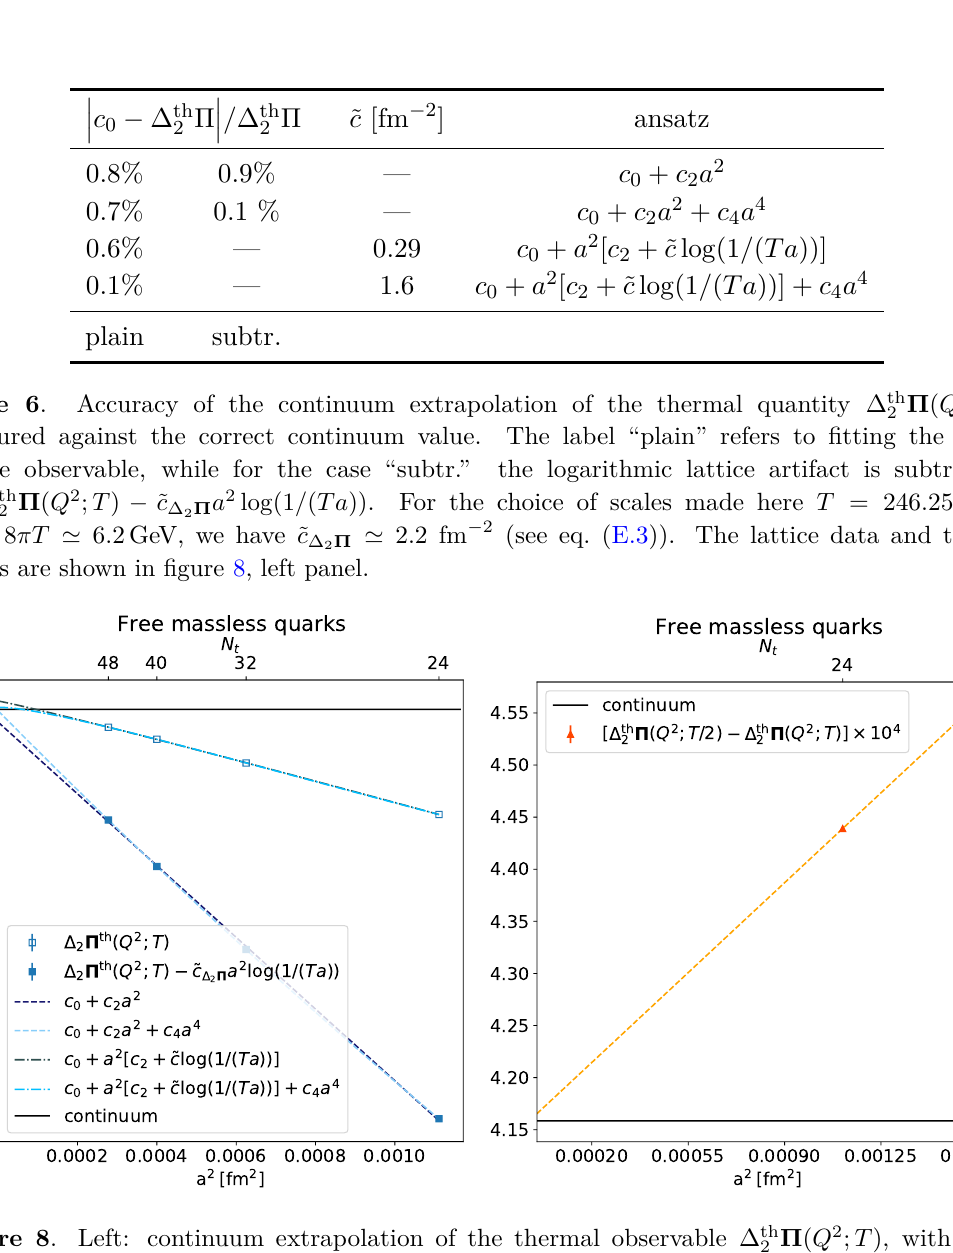
2 N = 48 for the temperature- T/ 2 one, the difference between the lattice t